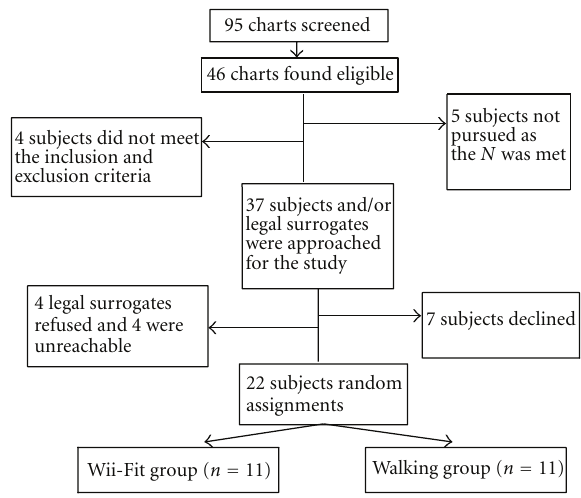
Figure 1: Subject recruitment and